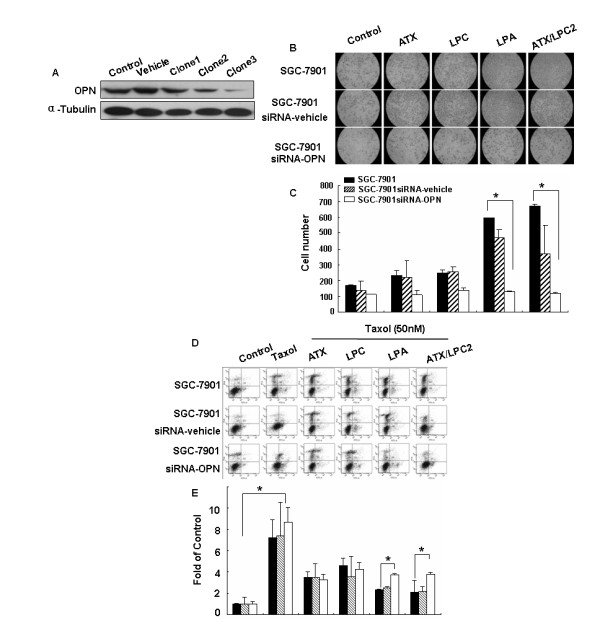
Requirement of OPN in migration induced by ATX-LPA axis protects against Taxol-induced apoptosis in SGC7901 cells. (A) Verification of siRNA knockdown of the OPN protein by Western blot showed a significant reduction of OPN protein in clone3 (SGC7901-siRNA-OPN). (B) The effect of OPN on ATX-LPA-induced migration was assayed using a Transwell assay. Either SGC7901, SGC7901-siRNA-vehicle, or SGC7901-siRNA-OPN cells (1 × 105) were added in the upper chambers of the transwells, incubated in DMEM/0.1% BSA or medium containing ATX, LPC, LPA, ATX/LPC2 and allowed to migrate for 48 hours at 37°C. Migrated cells on the lower chamber were quantified. (D) Flow cytometric analysis of apoptosis: SGC7901, SGC7901-siRNA-vehicle, or SGC7901-siRNA-OPN cells were treated with Taxol (50 nM) in the absence or presence of each group: ATX, LPC, LPA, ATX/LPC2 or DMEM/0.1% BSA for 24 hours. Apoptosis was analyzed by flow cytometry. Data shown in Figure 4C and E represents the mean ± SD from three individual experiments. Data are mean ± SD of triplicate determinations. Statistical analysis was performed using Student's t test. *p < 0.05.